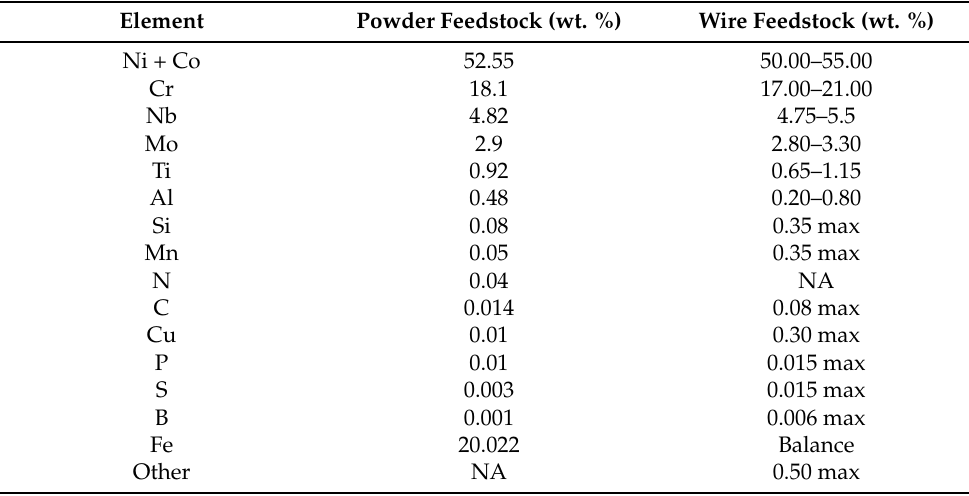
Table 2. Chemical composition of the powder and wire feedstock [15,16].